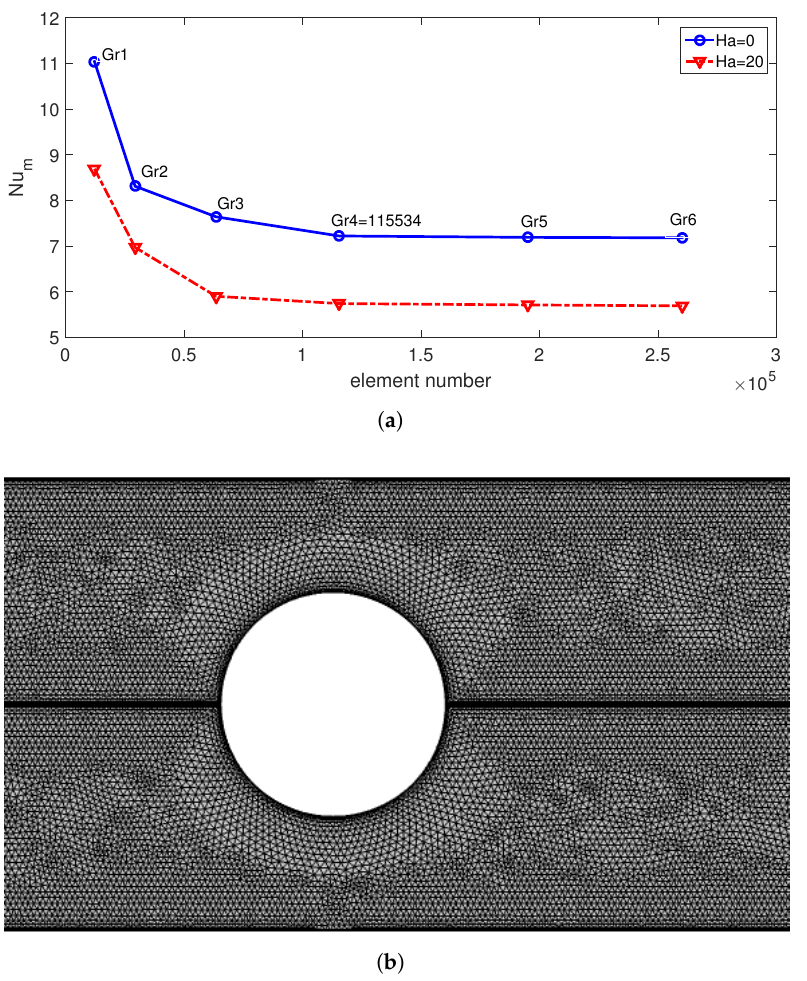
Figure 2. Grid independence test results: Average Nu variations for different grid sizes at two MaF strengths of the upper domain ( a ) and grid distribution ( b ) (Re1 = Re2 = 200, Rew = 100, Ha2 = 10, H = 8 w, r = 4